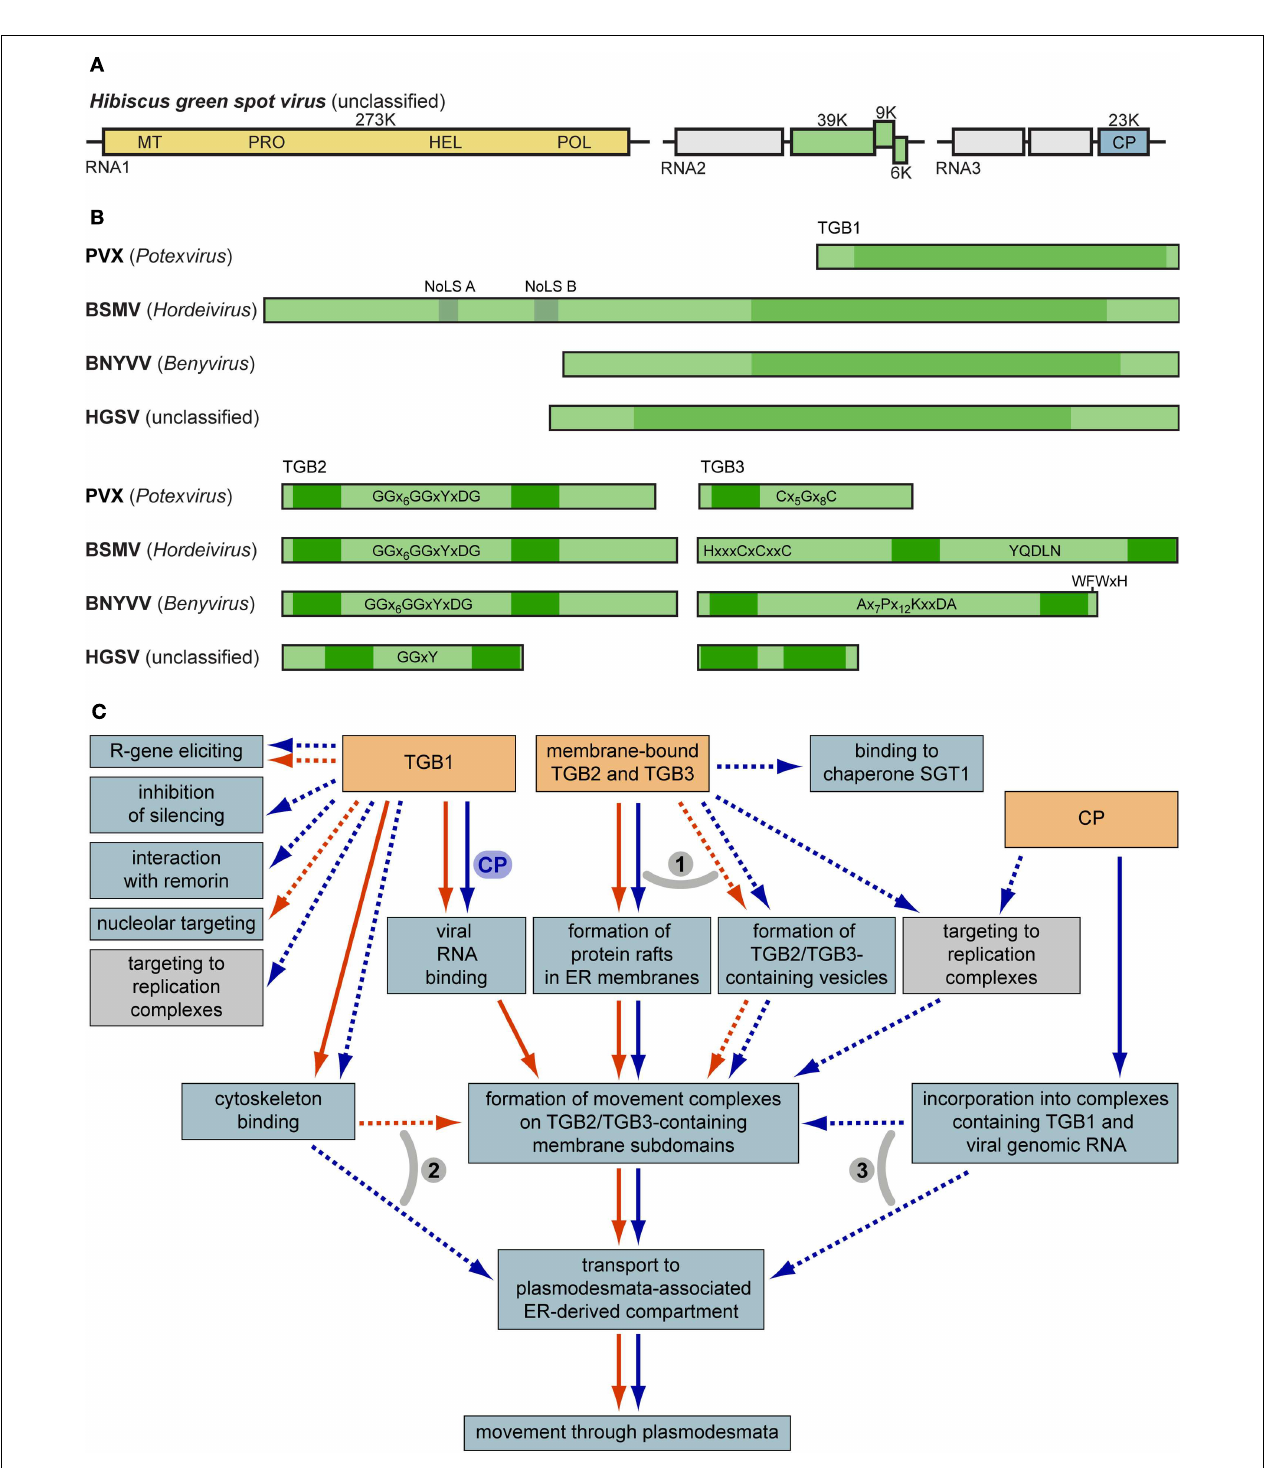
shown. Dark green boxes indicate hydrophobic transmembrane sequence segments. (C) General scheme ofTGB-mediated intracellular movement and interactions of macromolecules. Processes specific for potex-like and hordei-likeTGBs are shown by blue and red arrows, respectively. Note that the box ‘binding to chaperone SGT1’ means a functional interaction between TGB3 and SGT1 (Ye et al., 2012).Transport steps common for both potex- and hordei-likeTGBs are shown by parallel arrows. Processes that are